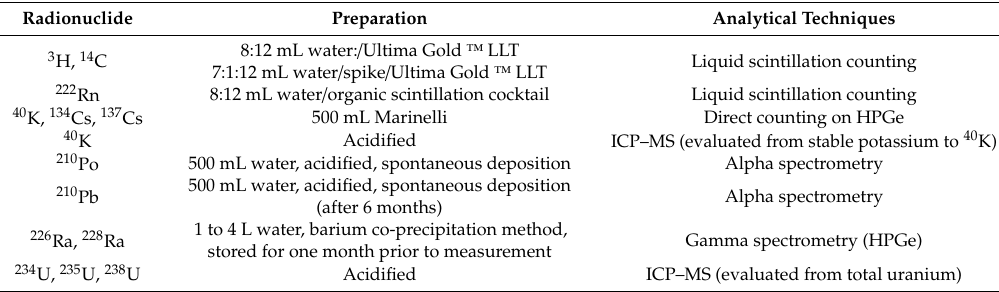
Table 1. Summary of the methods used for the analysis. HPGe, high-purity